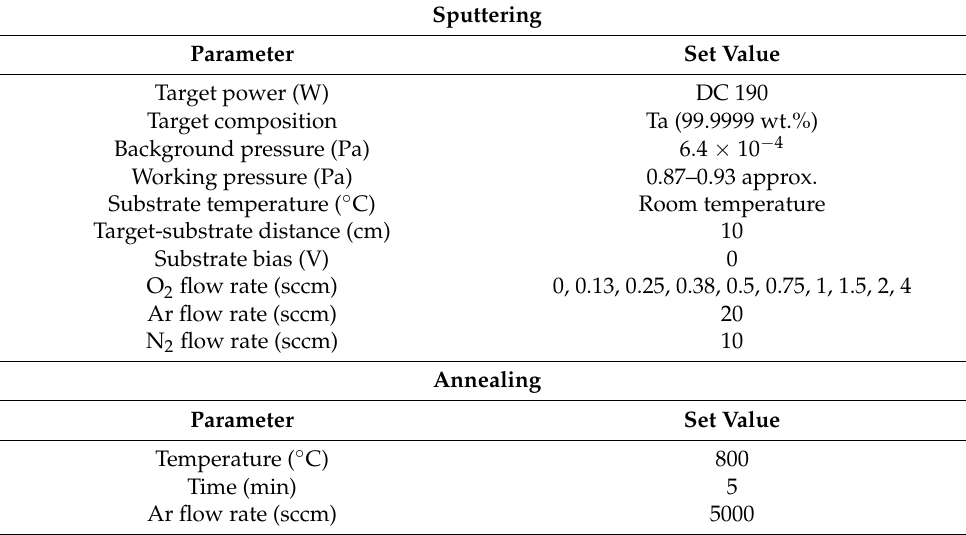
Figure 1. Experimental procedure and plan. Table 1. Parameters for PVD and rapid thermal annealing